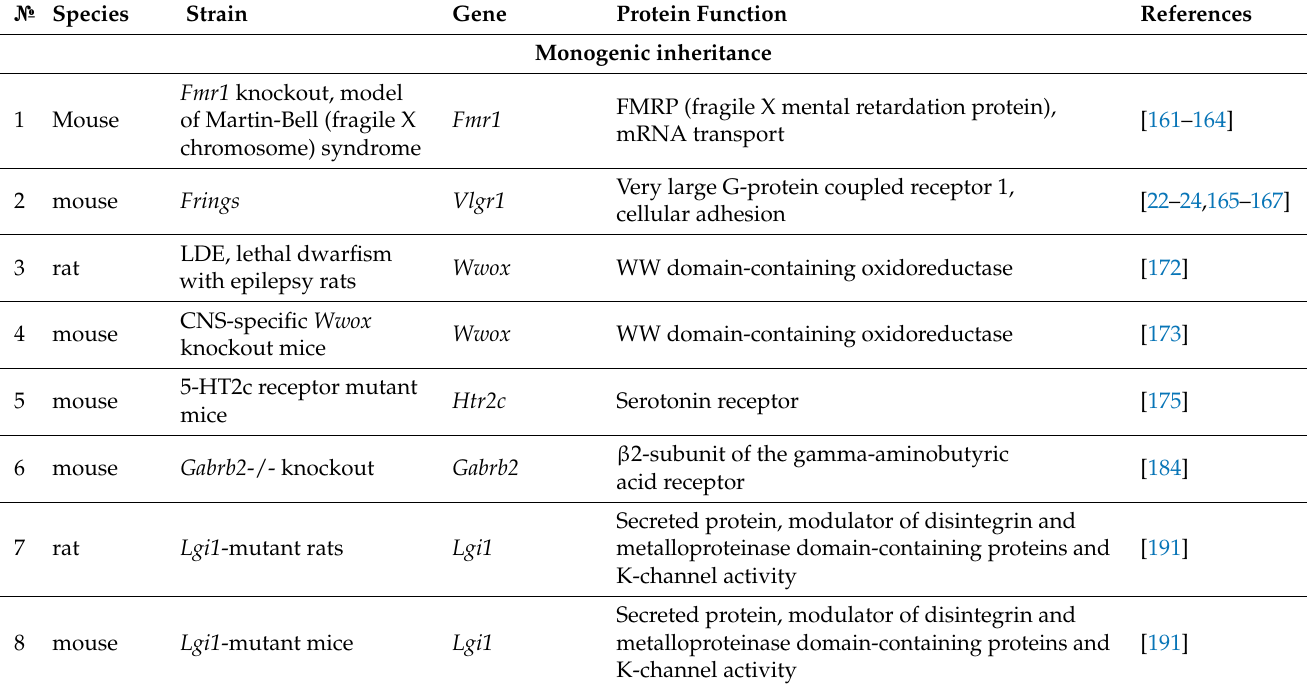
Table 1. Rodent strains—AE models, with description of the confirmed or hypothetical epilepsy- associated